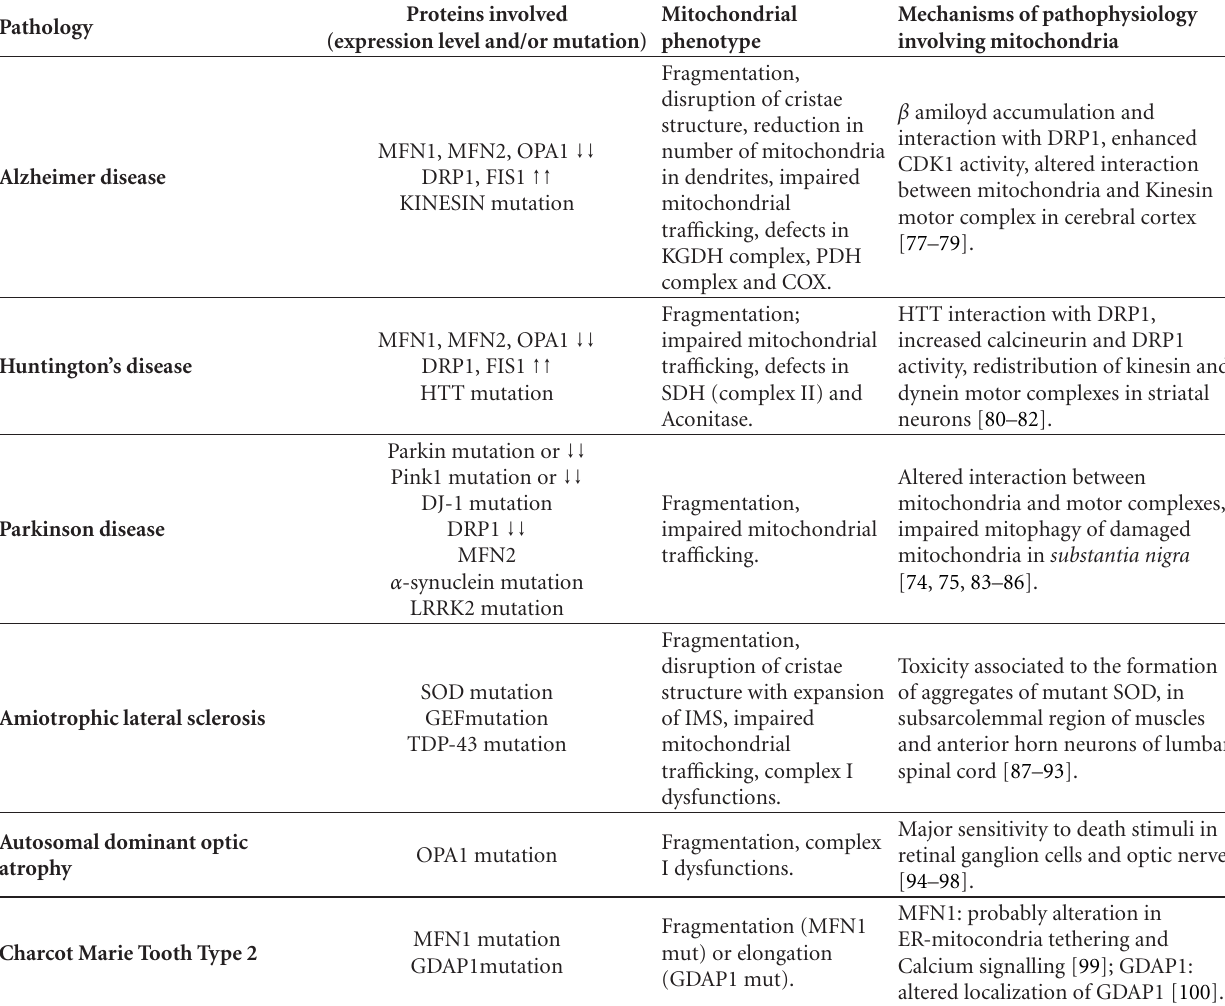
Table 2: Mitochondrial dynamics and neurodegenerative